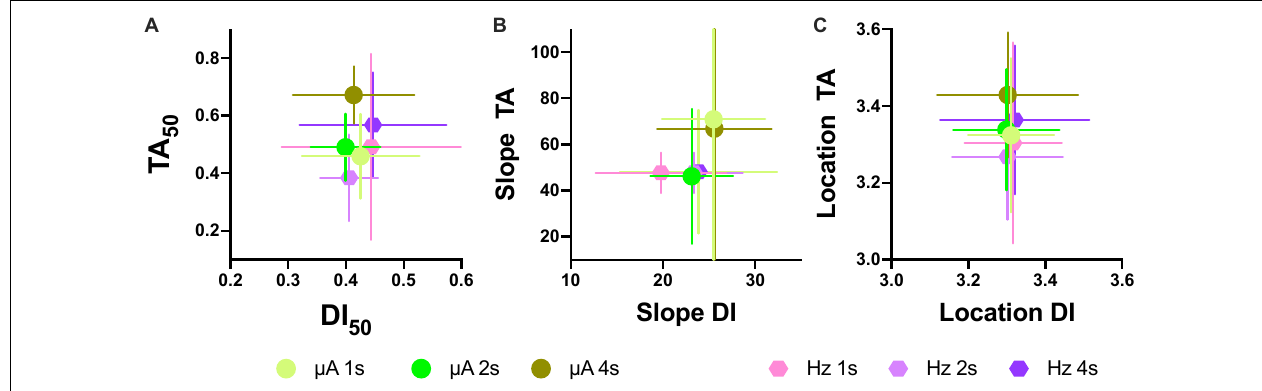
FIGURE 11 | Individual relations between TA50 to DI50 after intensity or frequency variations (A) . Relation to mean slope (B) and location parameters (C) after intensity or frequency variations (each point N = 5 ± S.E.). Horizontal error bars are for DIs, while vertical error bars are for TAs.